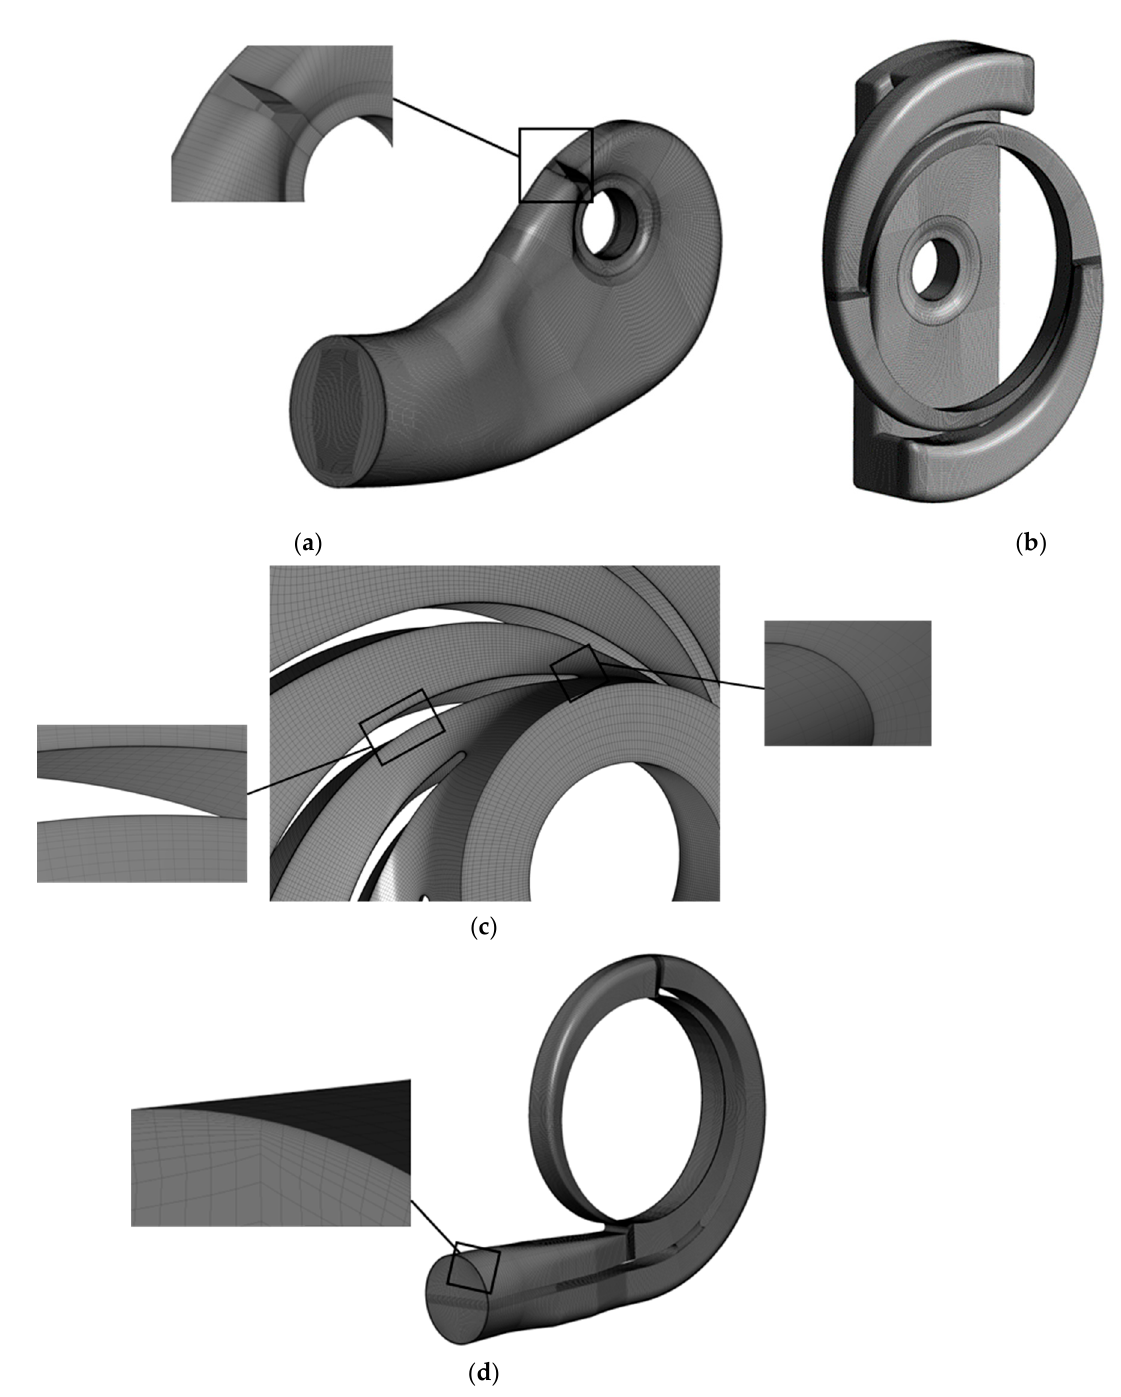
Figure 2. Structured mesh of all domains, which includes ( a ) suction chamber, ( b ) inter-stage flow channel, ( c ) impeller, and ( d ) double volute.